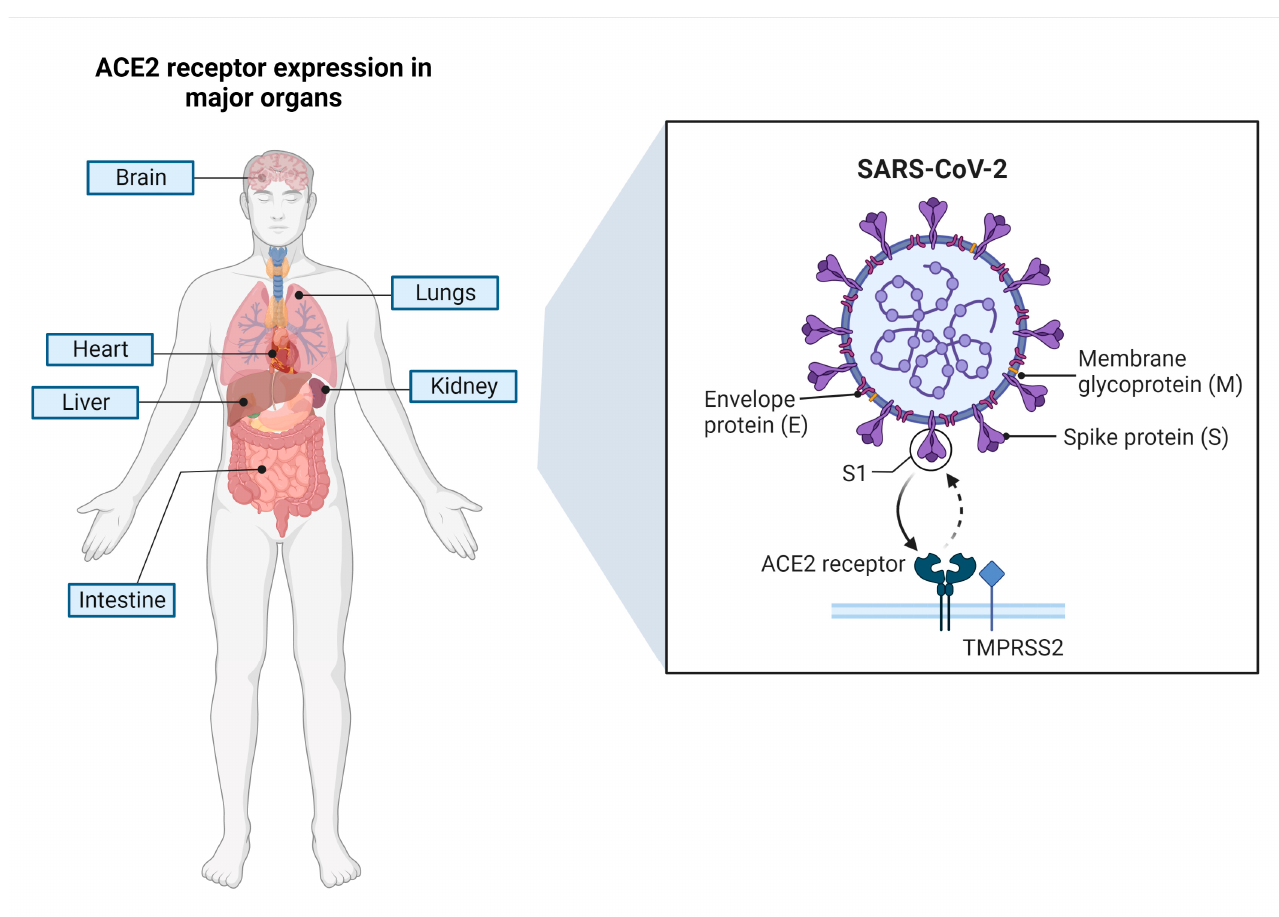
Figure 3. SARS-CoV-2 and host cell interaction. Major proteins, such as the spike (S), membrane (M), envelope (E), and nucleocapsid (N) proteins are indicated. The receptor (ACE2) from the host cell is displayed.